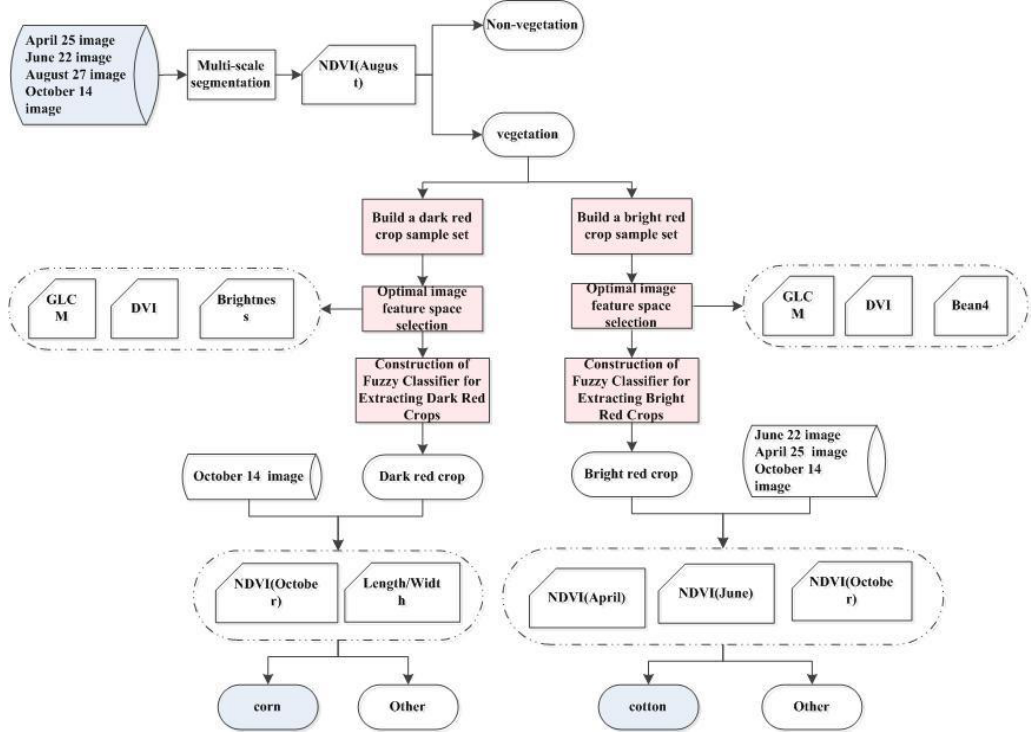
Figure 3. Corn and cotton information extraction flow chart